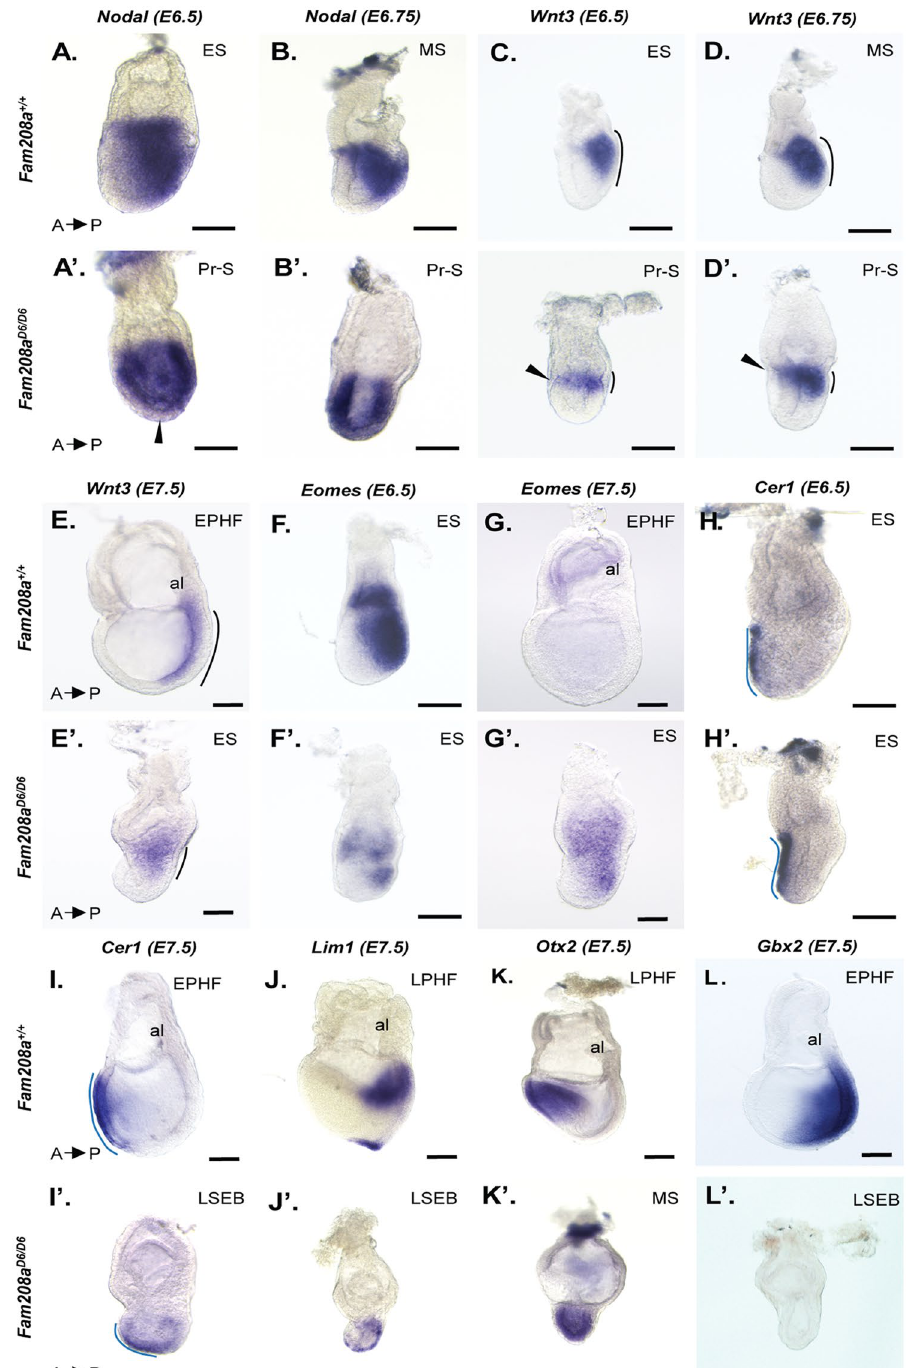
Figure 3. Gene marker expression in Fam208a D6/D6 mutant embryos. Whole mount in situ hybridization at E6.5-E7.5 of Fam208a D6/D6 mutants ( A’–L’ ) and their wild-type littermates (A–L). ( A’–D’ ) Posterior epiblast markers Wnt3 and Nodal fail to be completely down-regulated anteriorly in mutant embryos at E6.5–6.75. (F’) Eomes (key-regulator of EMT and inducer of mesoderm) is down-regulated in E6.5 mutant embryos. ( I ’) complete absence of Gbx2 (posterior neuroectoderm; hindbrain marker) ( J ’) with expanded (both anterior and posterior) Otx2 (anterior forebrain marker) expression domain in E7.5 mutants. ( H ’) slight Lim1 (anterior PS marker) expression is seen at E7.5 in mutants when compared to wild type. ( K’,L ’) Note that AVE migrates correctly in mutants at E6.5. At E7.5, Cer1 is expressed in the ADE overlaying future head formation, while in mutants Cer1 expression is reduced and remains in the distal epiblast. Dashed line in black indicates the length of the primitive streak and in blue indicates the length of the AVE. Scale bar: 30 µ m. ES, Early streak; MS, Mid- streak; Pr-S, Pre-streak; EPHF, Early pre-head fold; LSEB, Late streak, early allantoic bud; LPHF, Late pre-head fold; al,